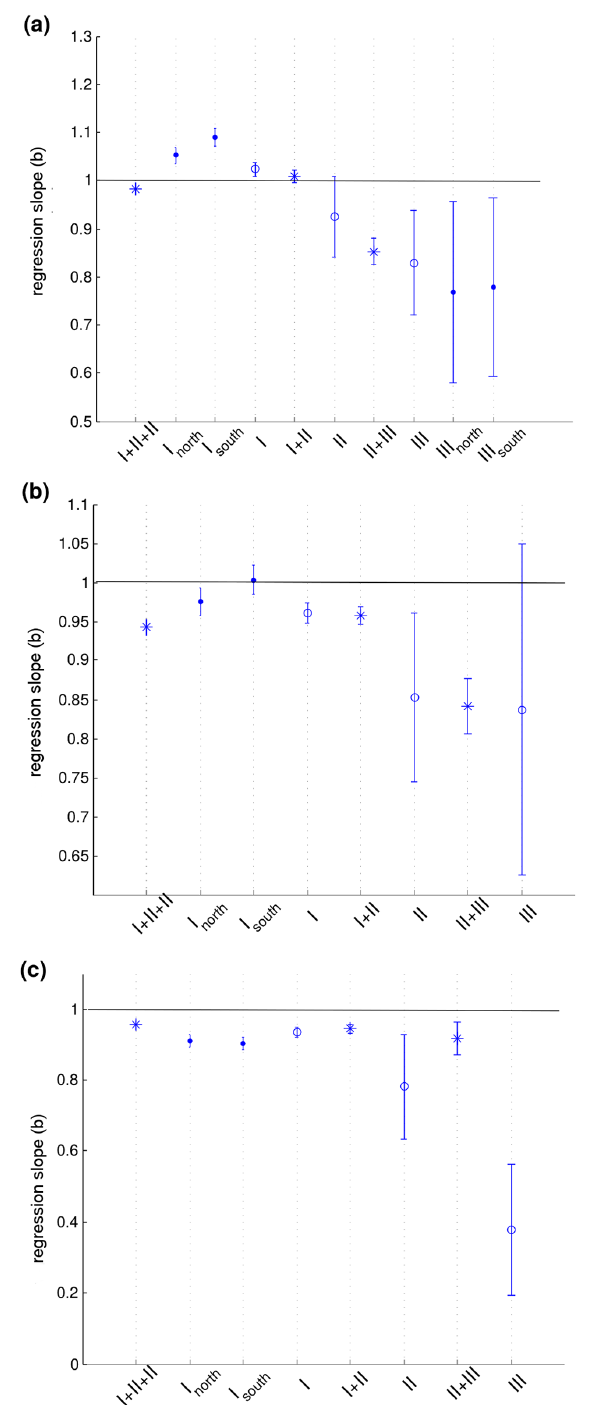
Fig 2. Model slopes with 95% confidence intervals. For scaling relationships of SCW to SCL (panel (a)), BD to SCL (panel (b)), and BD to SCW (panel (c)). In addition to slopes of regression equations specific for life stage subsets ( ‘ I ’ , ‘ II ’ , and ‘ III ’ , marked with circles), and combined data sets ( ‘ I + II ’ , ‘ II + III ’ , and ‘ I + II + III ’ , marked with asterisks), we show slopes of regression equations specific for regional subsets, which describe either exclusively posthatchlings ( ‘ I north ’ , ‘ I south ’ ) or nesting adults ( ‘ III north ’ , ‘ III south ’ ), all marked with dots. Analysis of regional subsets is described in section Analysis of regional subsets ‘ north ’ and ‘ south ’ . Horizontal full line represents the slope of an isometric model ( b = 1).